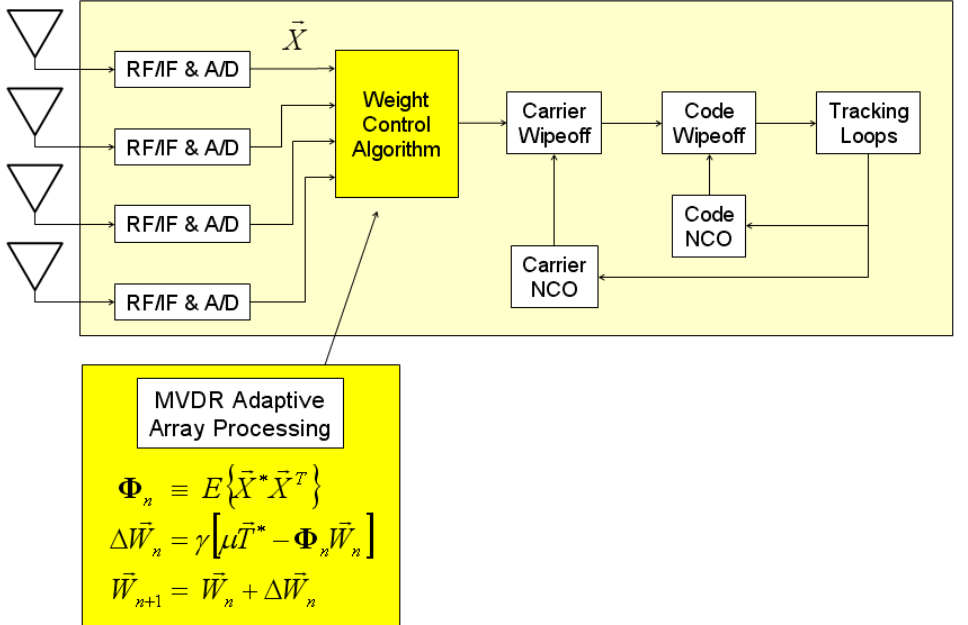
Figure 3. Adaptive RFI cancellation by MVDR processing with given array steering vectors from the phase alignment in Figure 2.